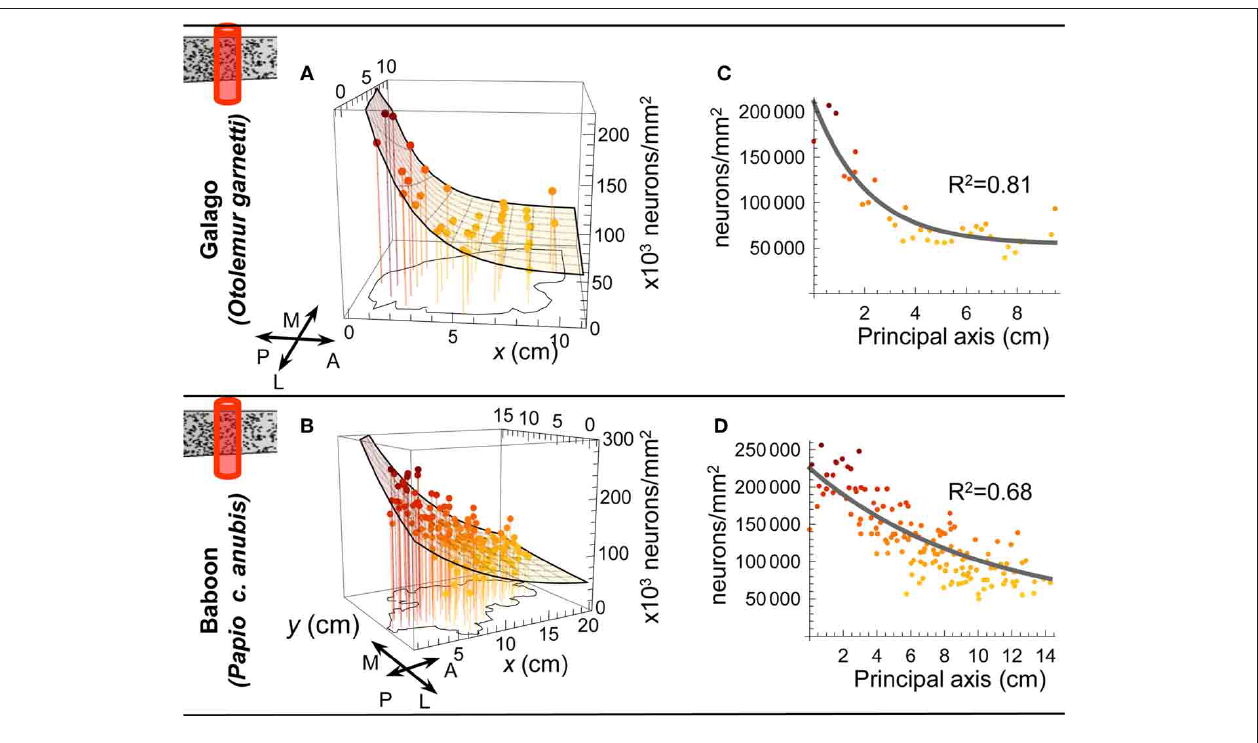
FIGURE 3 | Neurons per unit column. (A and B) Model surfaces fitted to the to the number of neurons under a square millimeter of cortical surface in each of the samples tested by Collins et al. (C and D) As for the neuron